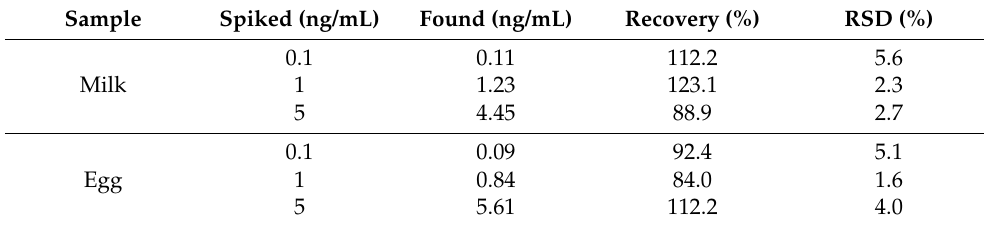
Table 2. Detection of FF in milk and egg samples.